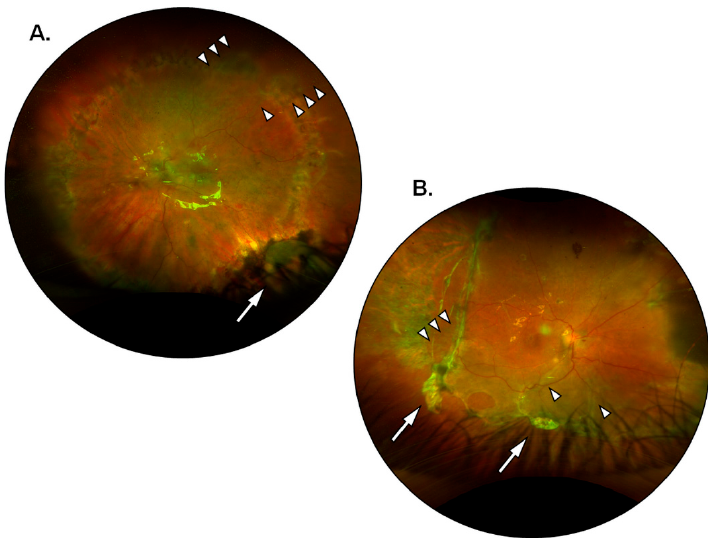
Figure 1. PVR recurrences following hAMP-V. ( A ) Fundus images of a partially successful hAMP-V showing a four-quadrant wide retinectomy with a large hAM patch applied adjacent to the inferior margin. The image was acquired at 1 month from surgery and shows initial recurrence of epiretinal PVR (multiple arrowheads) with a short subretinal strain (single arrowhead) over the superior margin of the retinectomy, distantly from the hAM patch. ( B ) Fundus image of a failed case of hAMP-V showing an extensive retinectomy of three quadrants with two hAM patches applied adjacent to its borders (arrows). The image was taken at 1 month from surgery and the patches appeared crumpled and opaque, with almost no ability to coat the exposed RPE. Recurrence of epiretinal PVR developed at the temporal margins of the retinectomy (multiple arrowheads) with subretinal strains radiating inferiorly from the optic disc (single arrowheads).